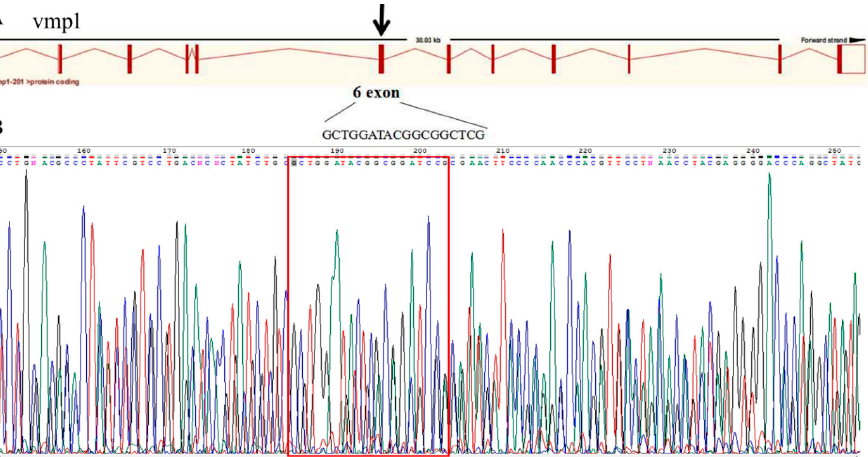
Figure 11. The sequence detection results for vmp1 knockout. ( A ) Gene architecture of vmp1 , showing the target site of the SgRNA. ( B ) The sequence detection results for vmp1 knockout for 24 hpf embryos. The red box indicates the knockout target site area.